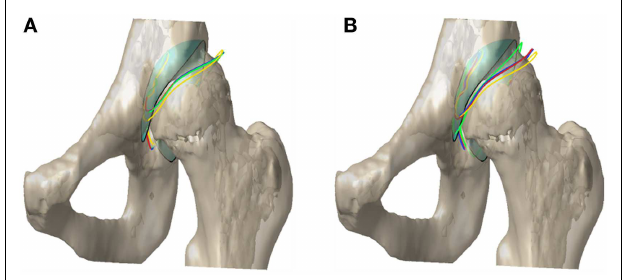
FIGURE 8 |Acetabular contact surface outline in the original and optimal alignment for (A) linear and (B) non-linear DEA .The colors red, blue, green, and yellow correspond to uniform, population-based (p-b) normal, p-b dysplastic, and CT-based cartilage thickness models, respectively.The cyan surface with the black outline represents the original alignment of the contact